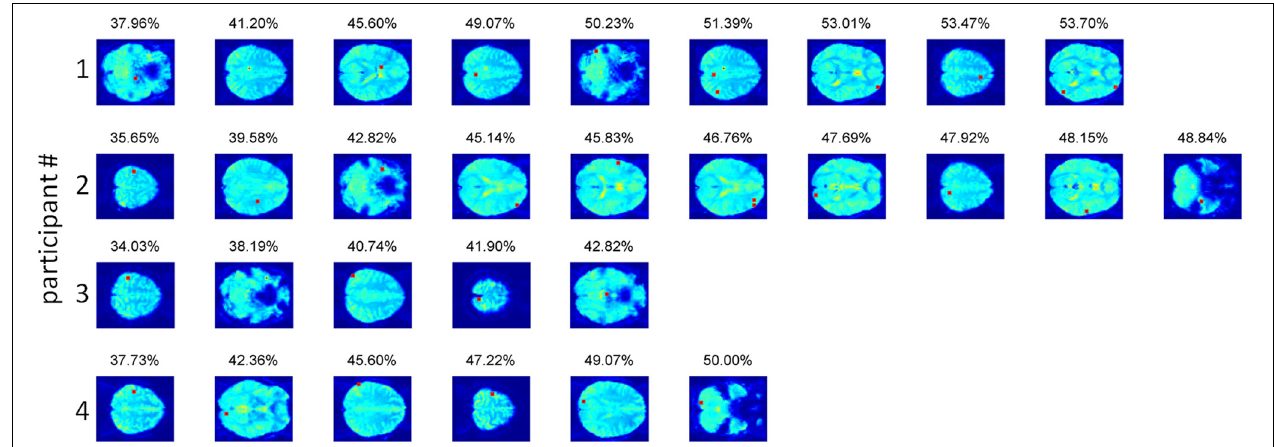
FIGURE 4 | The voxels contributing to the classification accuracy in the full-brain search approach. Voxels are displayed in the order of selection by the algorithm, with the obtained accuracy for the combined voxels displayed above the last selected voxel. In participants 2, 3, and 4 the precentral gyrus contains the voxel explaining most of the variance in